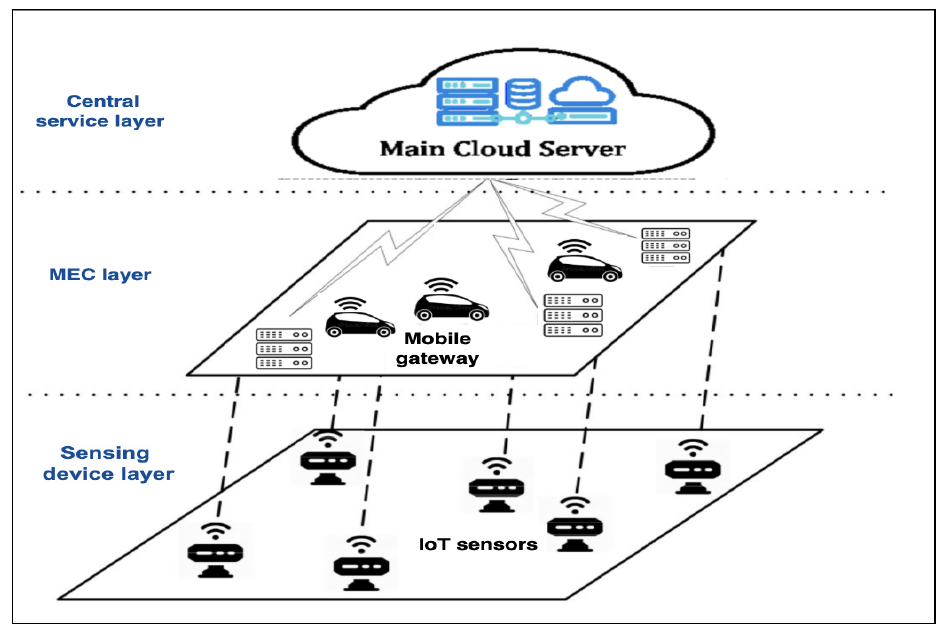
Figure 1. A three-layer architecture of EC ecosystem